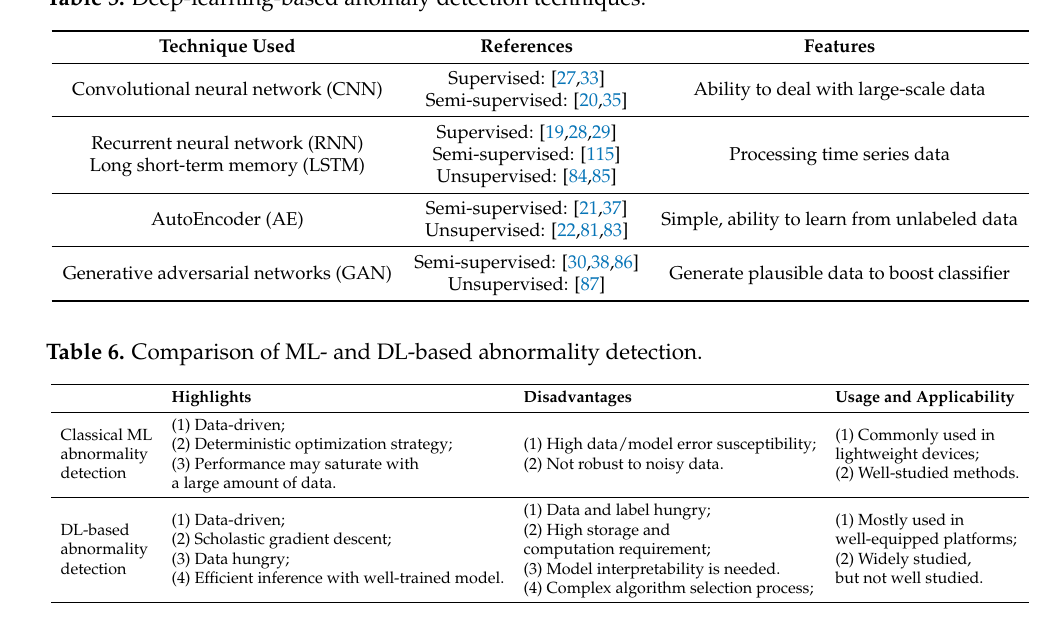
Table 5. Deep-learning-based anomaly detection techniques.